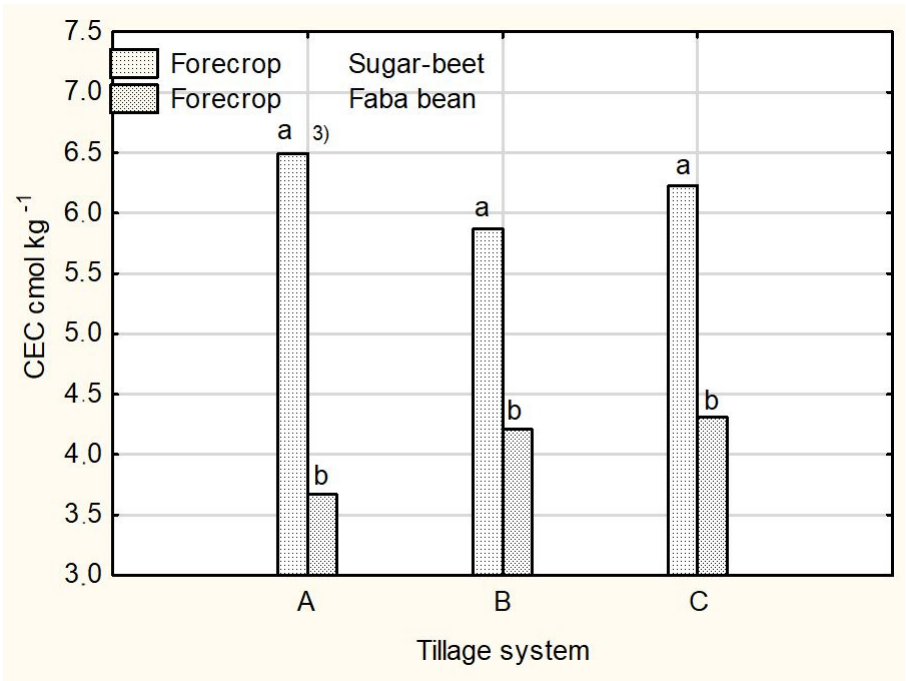
Figure 1. The effect of pre-crop on cation exchange capacity (CEC) in soil depending on tillage system, layer 0–0.05 m. 3) a, b—means marked by the same letter do not differ significantly at the significant level < 0.05. A—ploughing; B—ploughless using cultivator and string roller; C—direct sowing.